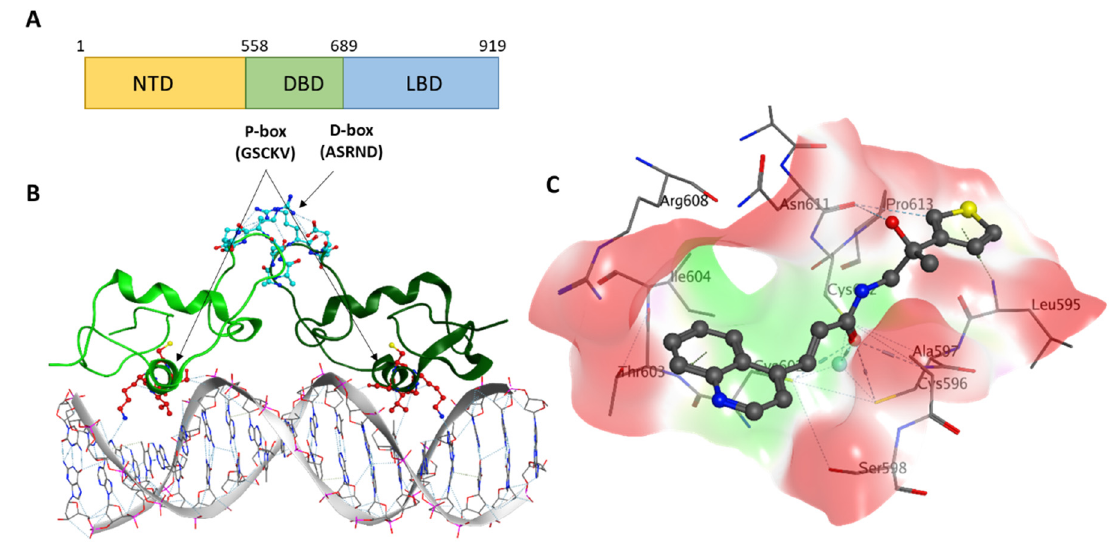
Figure 1. ( A ) Androgen receptor (AR) domain structure with P-box and D-box residues shown. ( B ) Crystal structure of the rat AR DNA binding domain (DBD) dimer (monomers are shown in different shades of green) bound to DNA (PDB (Protein Data Bank) code: 1R4I). The P-box residues are shown in blue, while D-box residues are in red. ( C ) Stick diagram model of VPC-17281.